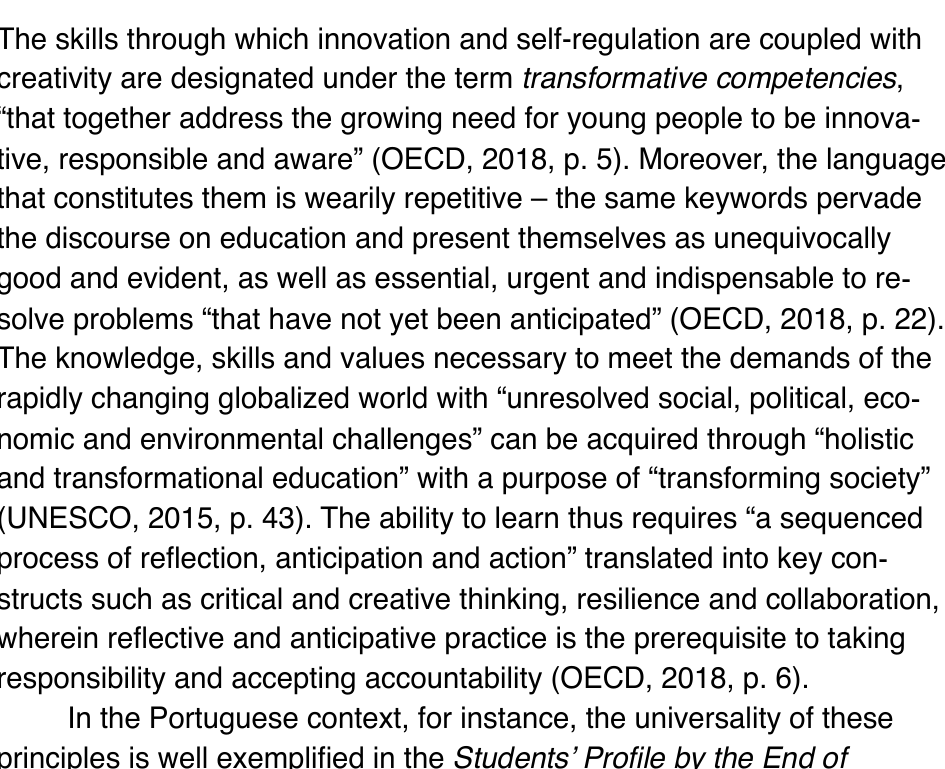
Figure 1: The OECD Learning Framework 2030: Work-in-progress. Source: The Future of Education and Skills Education 2030: the future we want (OECD, 2018, p.